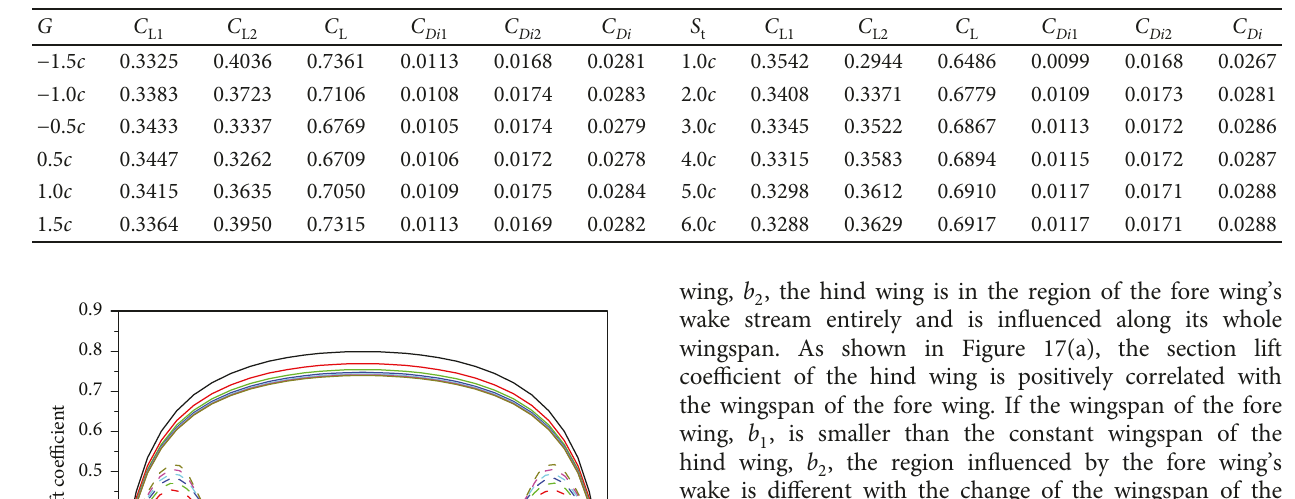
Table 2: Lift coe ffi cient and coe ffi cient of induced drag with the e ff ect of stagger and gap.